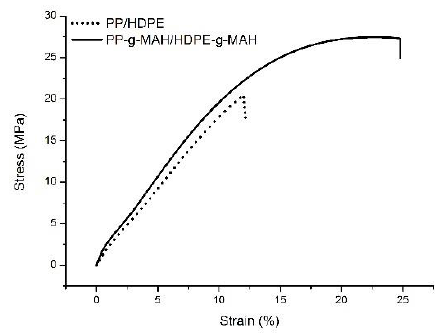
Figure 6. Linear and Lorentz-corrected SAXS profiles for PP / HDPE and PP- g -MAH / HDPE- g -MAH at room temperature.